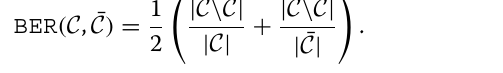
detection algorithm with brilliant performance, for a